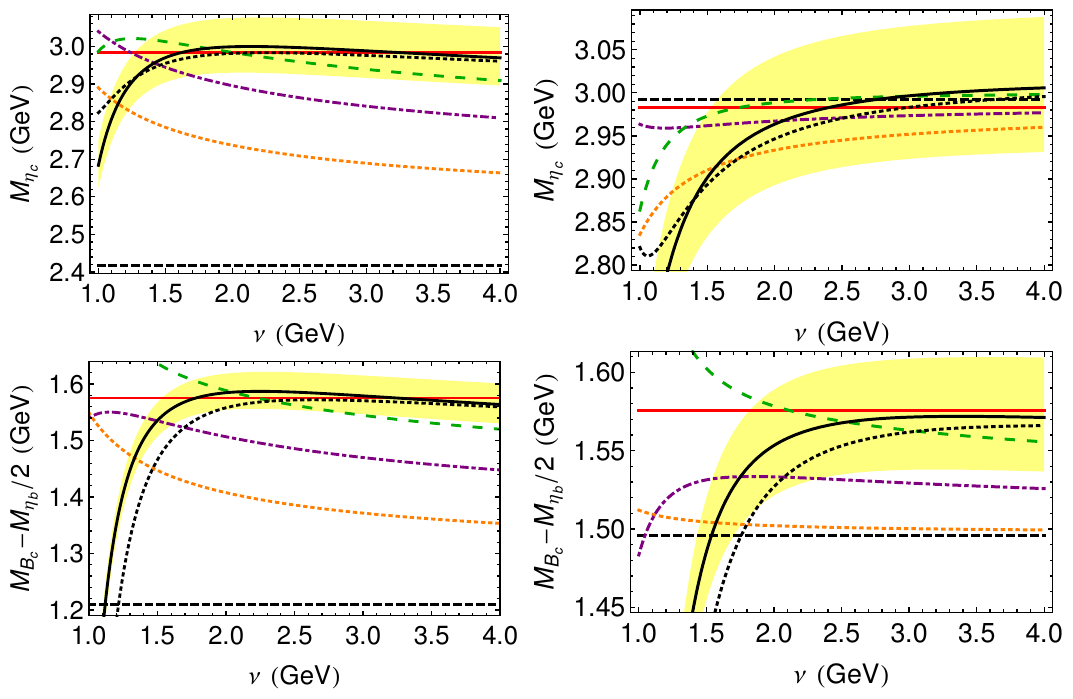
Figure 3 . Plots for (cid:23) f = 1 GeV, m c; RS = 1 : 209 (cid:0) 41 ( m c ) GeV, m c; RS 0 = 1 : 496 (cid:0) 41 ( m c ) GeV. Red line +41 +41 is experimental value, black dashed line is the sum of the masses. Orange dotted, purple dot-dashed and green long-dashed are the LO-NNLO contributions respectively. Solid black line is the N 3 LO, and the dotted black line the N 3 LO without (cid:14)E US . The yellow band corresponds to the error of 10 m associated to the uncertainty of m c . Upper left panel: plot of M (cid:17) in RS scheme. Upper c; RS = RS 0 c right panel: plot of M (cid:17) in RS’ scheme. Lower left panel: plot of M B (cid:0) M (cid:17) = 2 in RS scheme. c c b Lower right panel: plot of M B (cid:0) M (cid:17) = 2 in RS’ scheme. c b